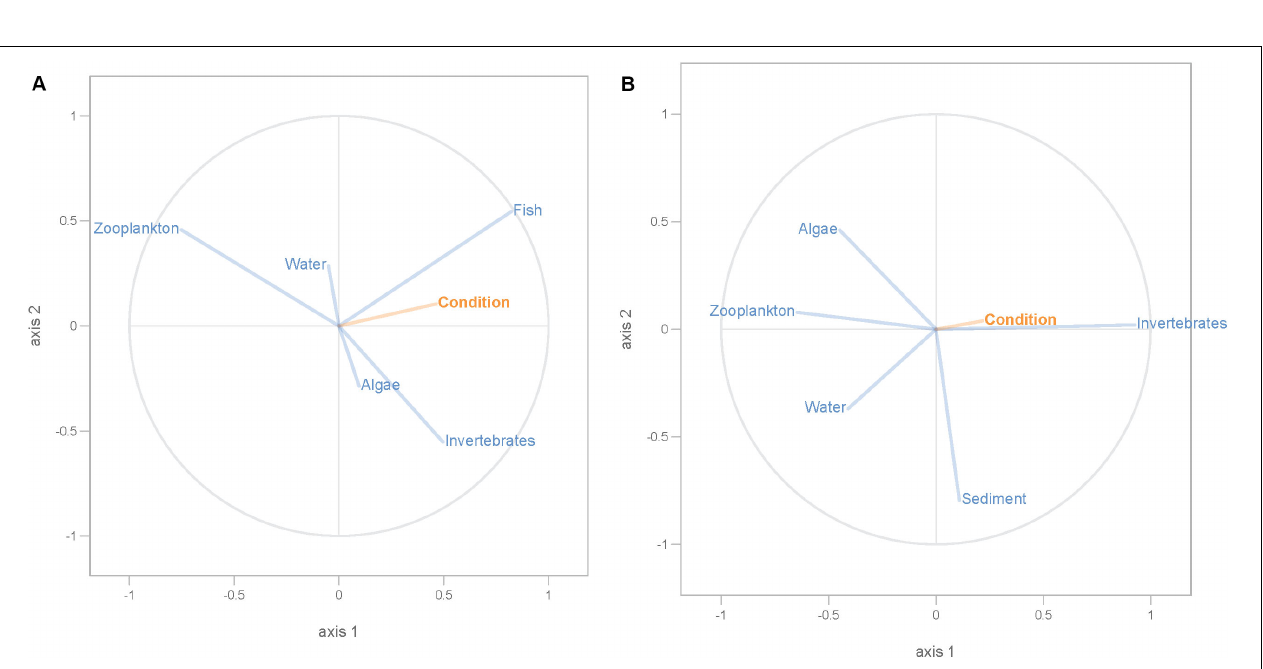
FIGURE 6 | PLS regression analysis between fish body condition and dispersal factors. Fish body condition was response variable (orange lines), and dispersal factors were predictor variables (blue lines) in perch (A) and roach (B) .